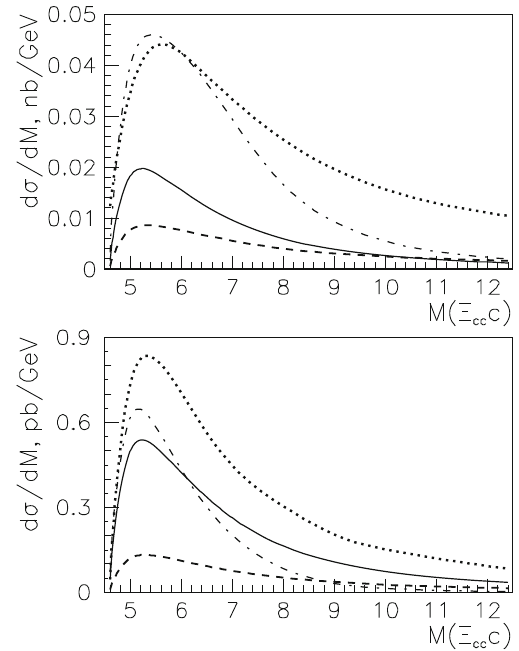
Fig. 7 The process g + g → Ξ cc + ¯ c + ¯ c ; the distributions over Fig. 6 The process g + g → Ξ cc + ¯ c + ¯ c ; invariant mass of the the fragmentation variable z as seen under the different kinematic Ξ + ¯ c system as seen under the different kinematic constraints. Upper cc > 20 GeV; constraints. Upper panel: dotted, p Ξ T > 5 GeV, p ∗ > 20 GeV; dashed, p Ξ > 20 GeV, T panel: dotted, p Ξ T > 5 GeV, p ∗ T > 20 GeV; dash-dotted, m ∗ < E ∗ / 3; T dashed, p Ξ T > 20 GeV, p ∗ > 20GeV;dash-dotted, m ∗ < E ∗ / 3;solid,factorizationcalculation T p ∗ > 20 GeV. Lower panel: dot- T solid, factorization calculation for p ∗ > 20 GeV. Lower panel: dotted, p Ξ > 20 GeV, p ∗ > 50 GeV; T for p ∗ T > 50 GeV; dashed, p Ξ > 50 GeV, T T ted, p Ξ T > 20 GeV, p ∗ T > 50 GeV; dash-dotted, m ∗ < E ∗ / 10; T dashed, p Ξ T > 50 GeV, p ∗ > 50 GeV; dash-dotted, m ∗ < E ∗ / 10; solid, factorization cal- T p ∗ > 50 GeV T solid, factorization calculation for p ∗ > 50 T culation for p ∗ T